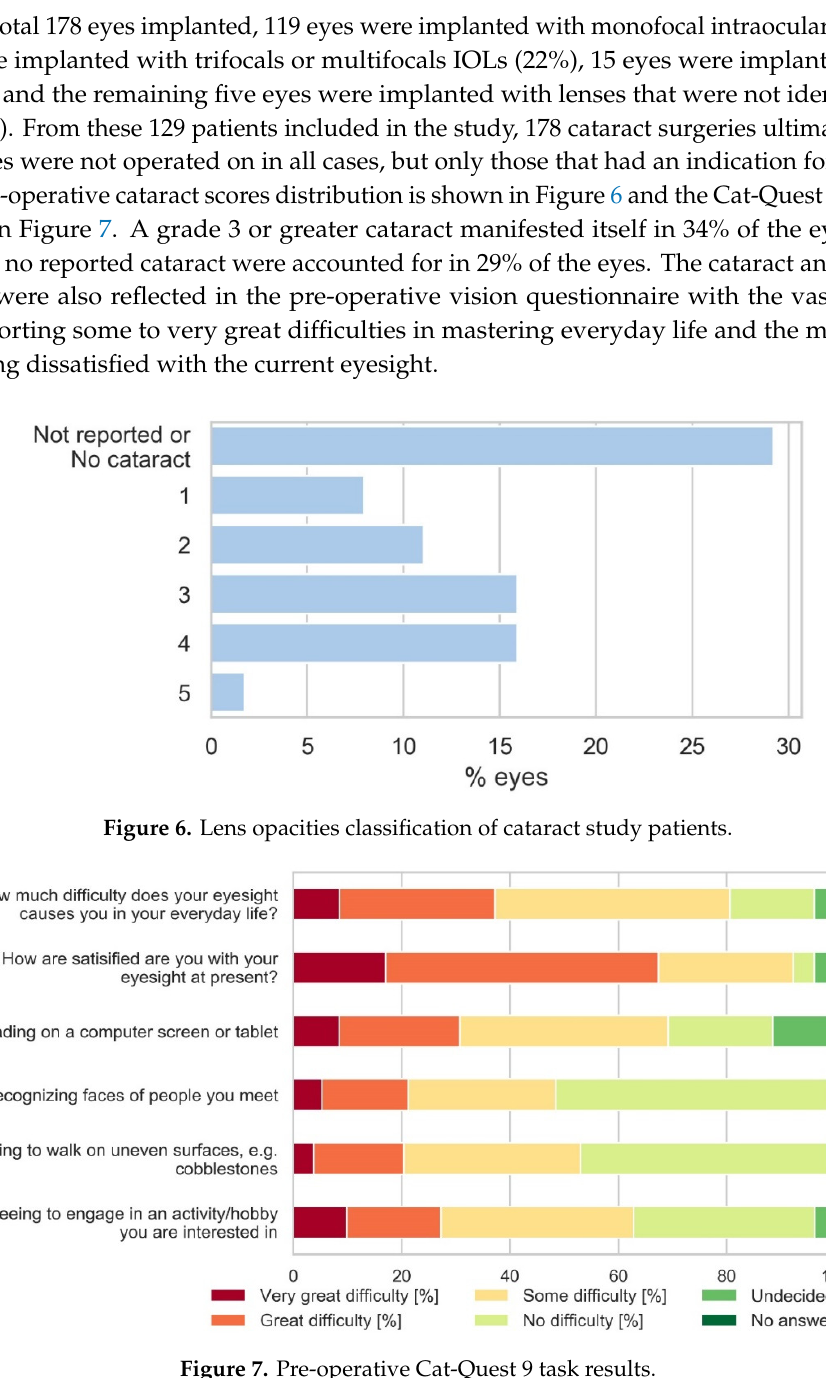
Table 2. Distribution of the preoperative corrected distance visual acuity and Lens Opacities Classification System (LOCS) III score of the patients separated by the answers in the usability questionnaire. Question